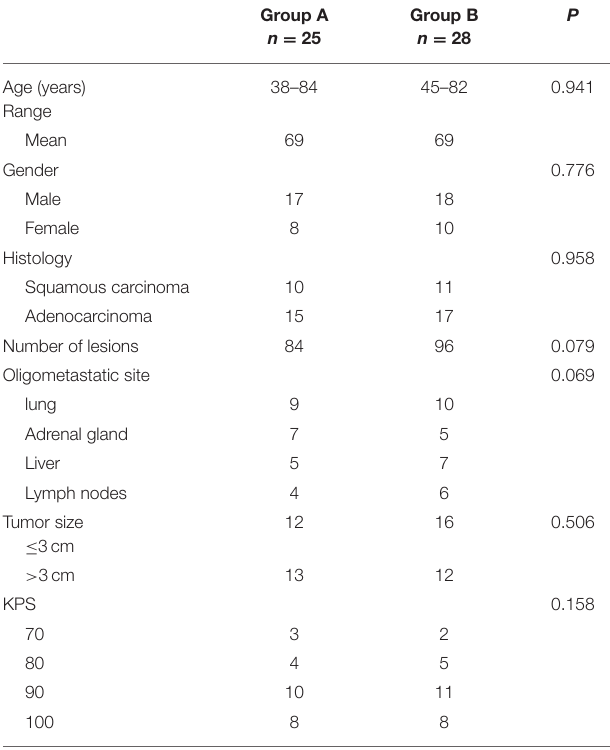
TABLE 1 | Patient